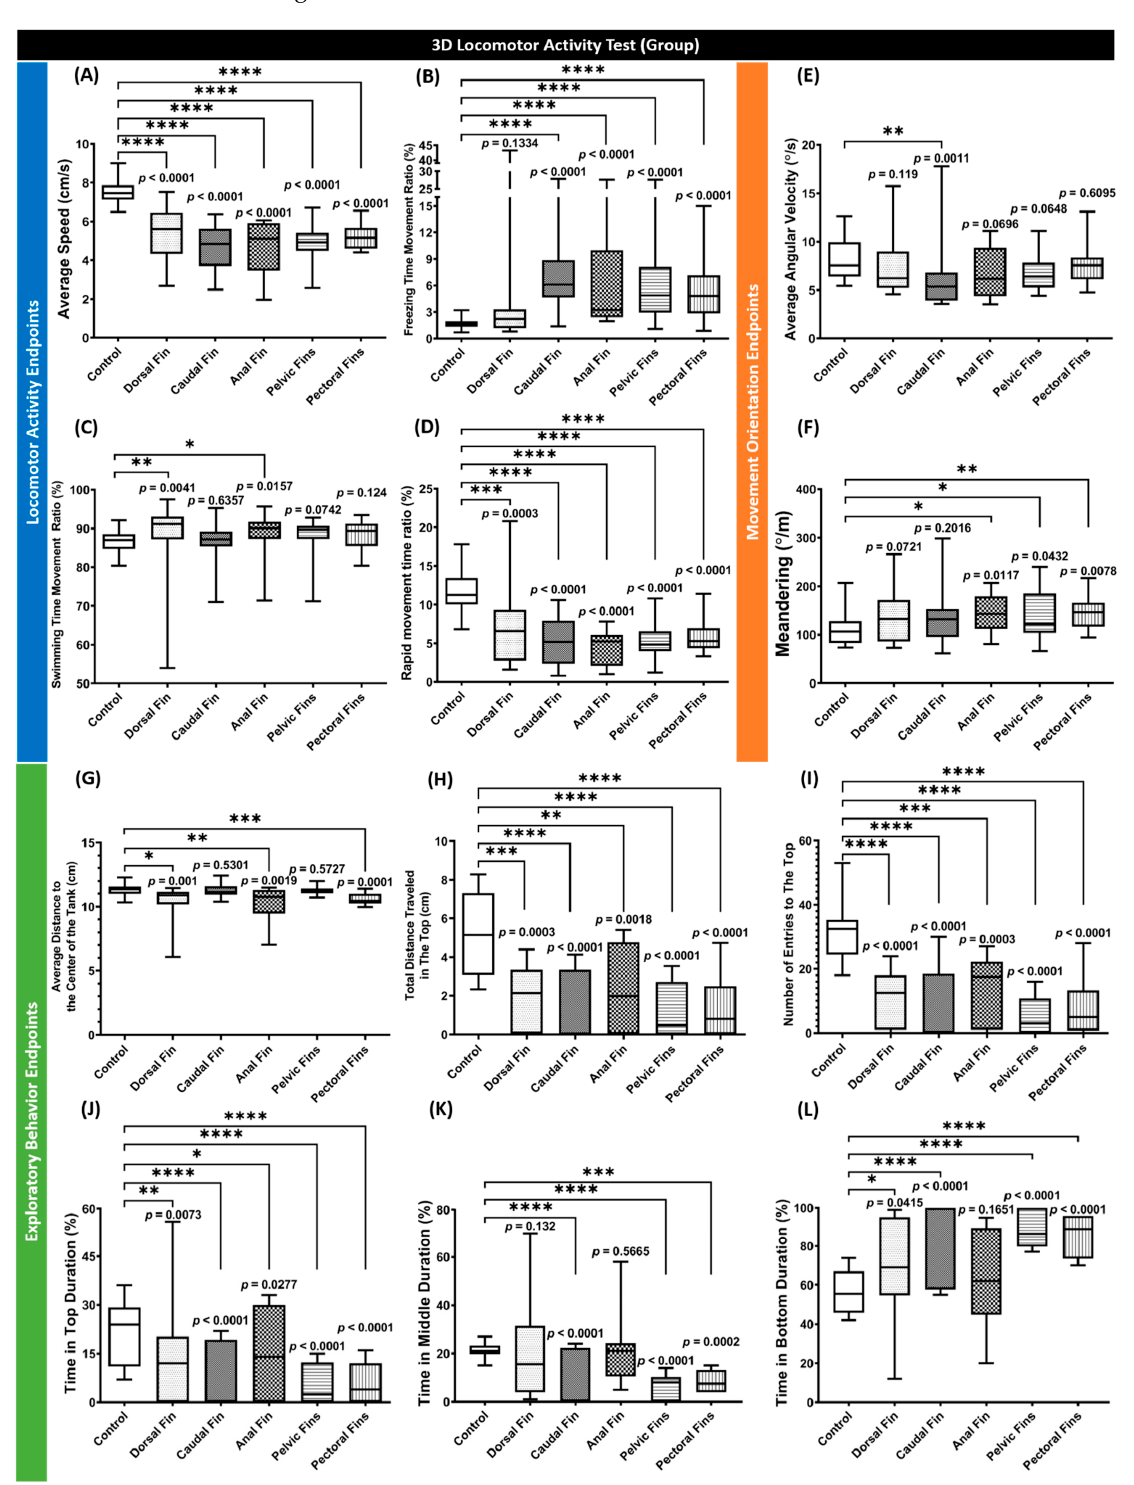
Figure 2. Comparison of grouped zebrafish behaviors in 3D locomotion test among fin-amputated groups and a control group (shoal size = six fishes) at 2 dpa. Twelve endpoints were measured and categorized into three groups. ( A ) Average speed, ( B ) freezing time movement ratio, ( C ) swimming time movement ratio, and ( D ) rapid movement time ratio belongs to the locomotor activity